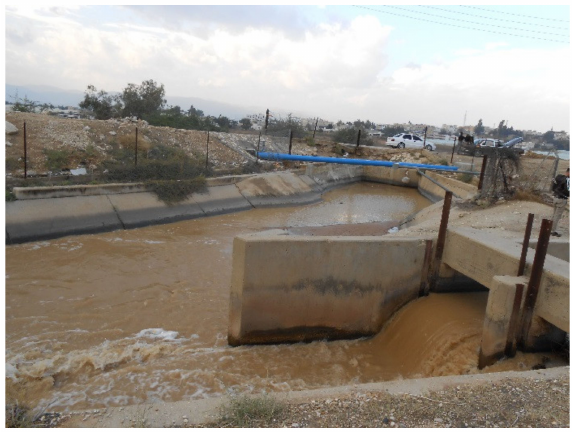
Figure 2. Diversion point at